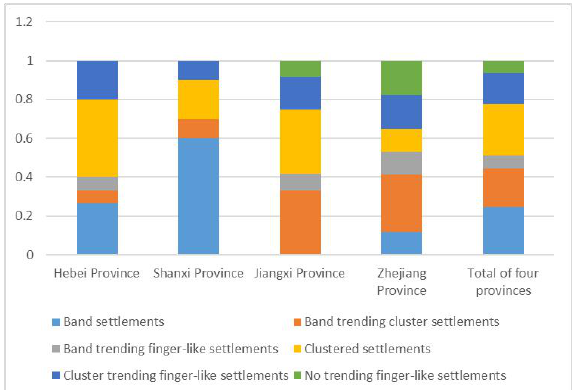
Figure 6 . Statistical histogram of the traditional village boundary fractal index.